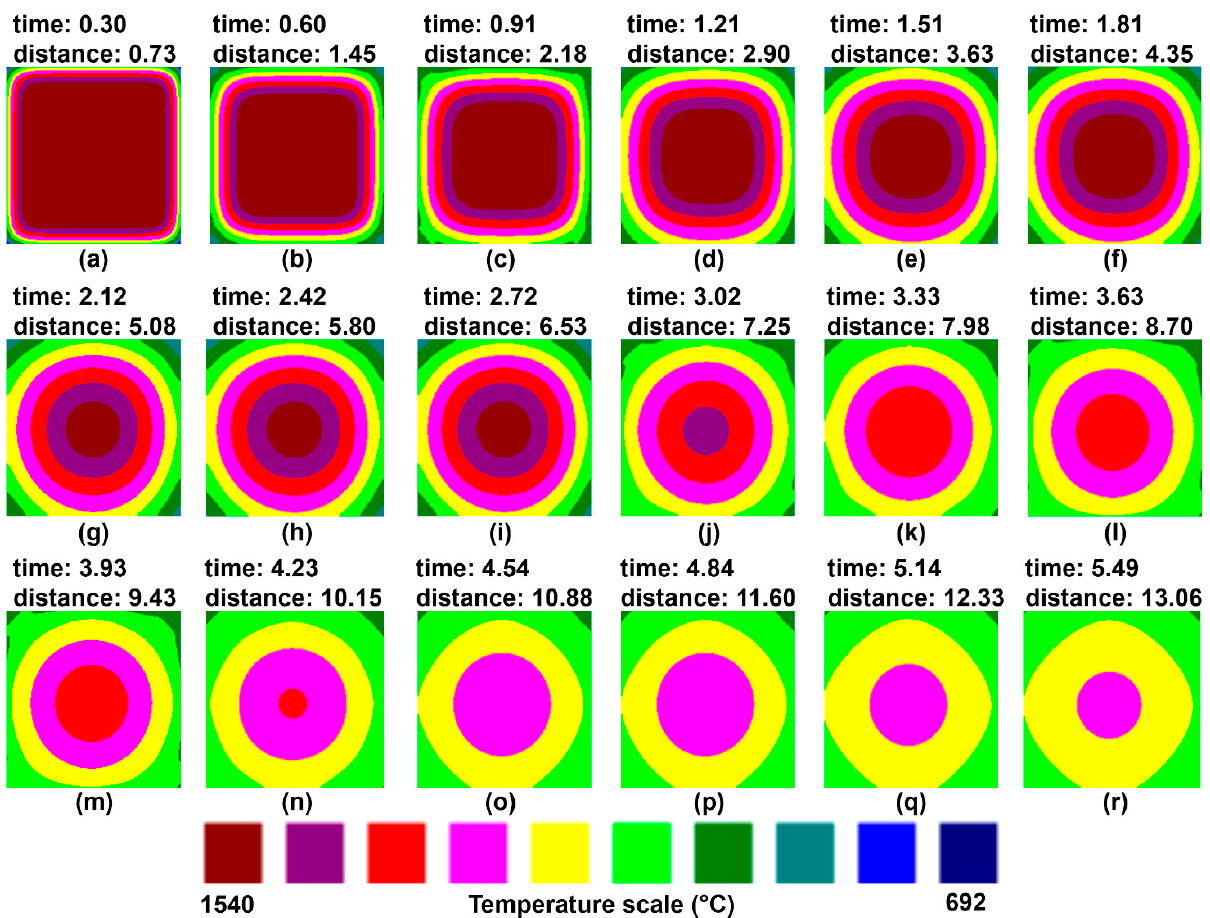
Figure 14. ( a – r ) Temperature profiles for steel top views; time (min) and distance (m).